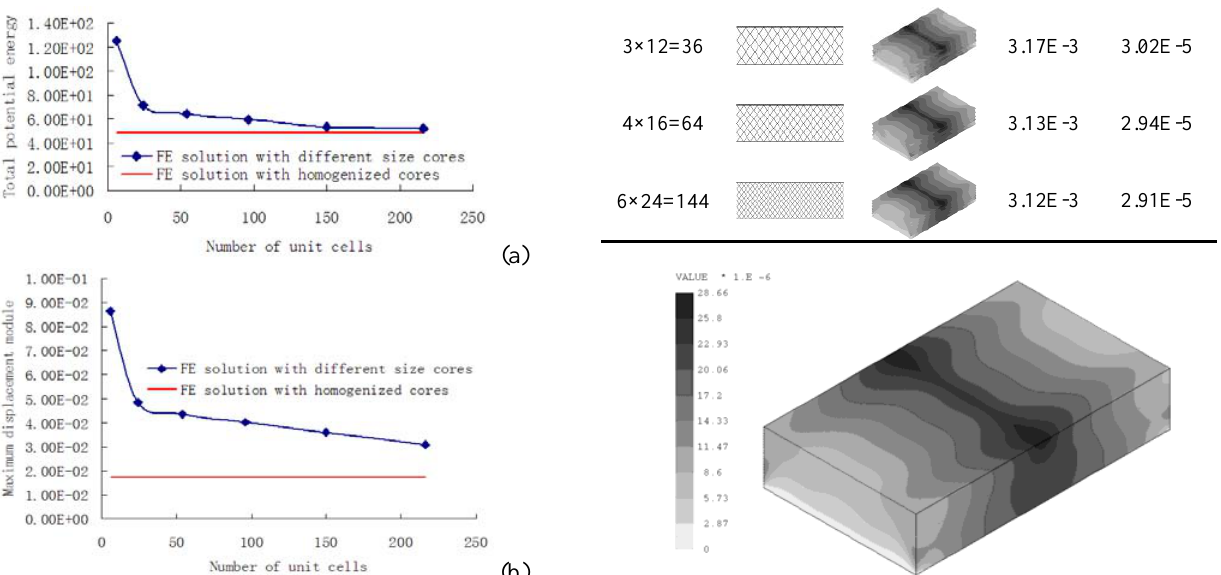
Fig.13. (a) Total potential energy and (b) Maximum dis- placement module of sandwich structure with the circle core the maximum disp umber of the unit cells that have been used in the sandwich core.